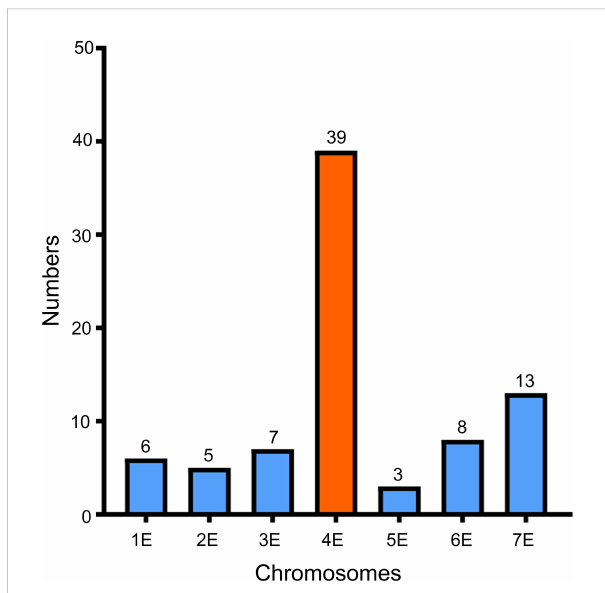
FIGURE 6 Alignment results of 81 speci fi c SLAFs to Th. elongatum genome using Bowtie